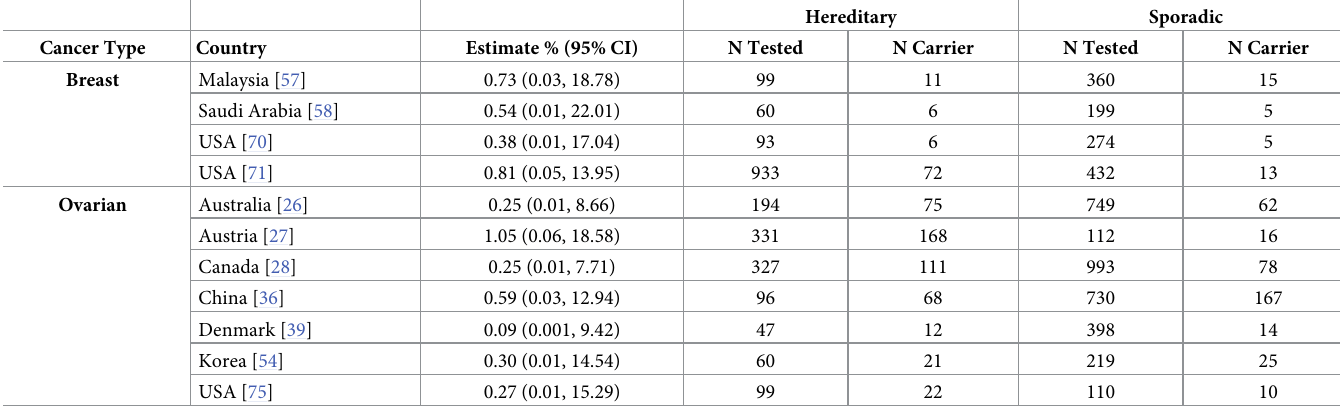
Hereditary Sporadic